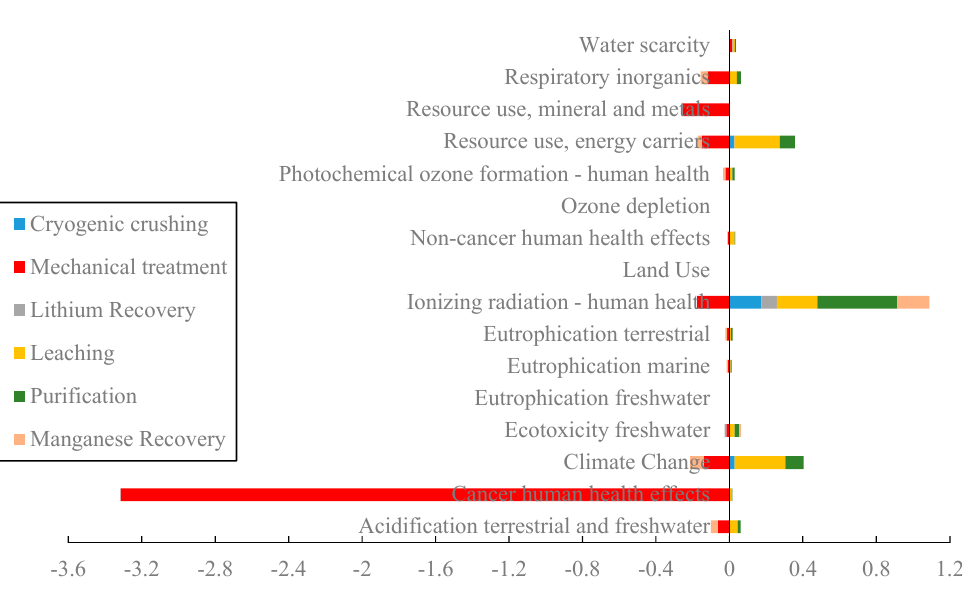
Figure 3. Results of normalization and weighting steps of LCA related to LiBat process (functional unit: 100 kg of treated waste).